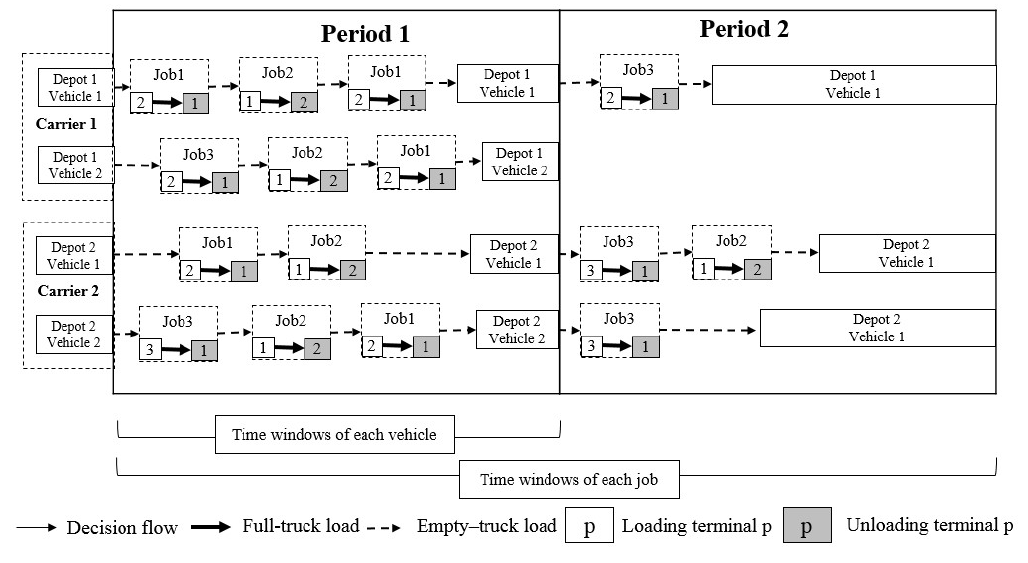
Fig. 2. An example of vehicle routing for two carriers with three jobs from two